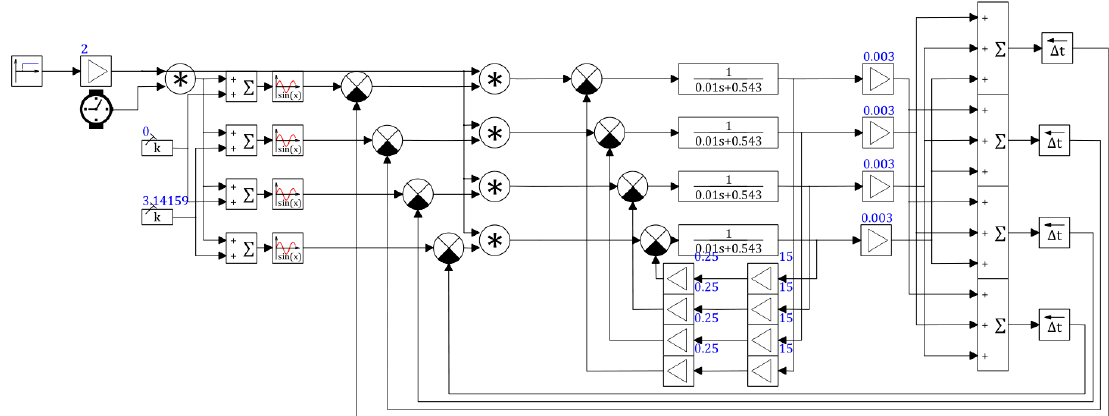
Figure 13. Mathematical model of a higher-capacity generator.